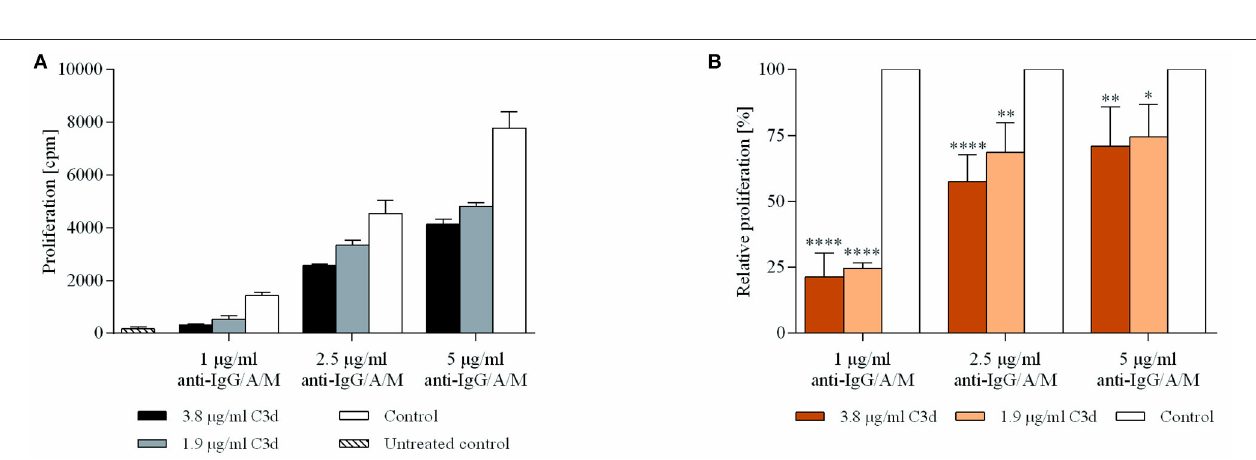
FIGURE 4 | C3d inhibits the proliferation of BCR activated human B cells. Resting human B cells were cultured with complexes consisting of either streptavidin-conjugated biotinylated anti-IgG/A/M (control) or streptavidin-linked biotinylated anti-IgG/A/M and biotinylated C3d in different concentrations as indicated. Cells were pulsed with 1 µ Ci/sample [ 3 H]-thymidine after 48h and harvested 20h later. Mean counts per minute (cpm) values ± SD of triplicate samples of a representative donor are shown (A) . The relative mean effect of C3d on proliferation ± SD in samples stimulated with BCR were calculated from three independent experiments (B) . * p < 0.05, ** p < 0.01, **** p <